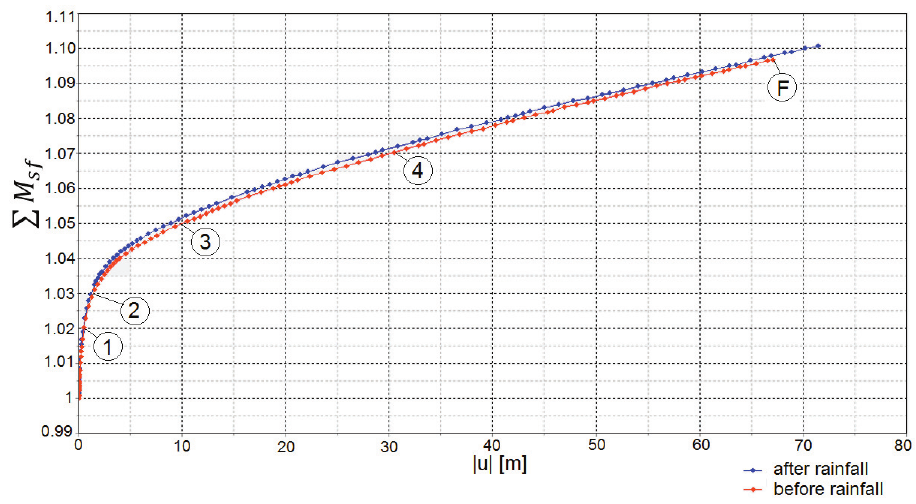
Fig. 11. Safety factor result for both cases – before and after heavy